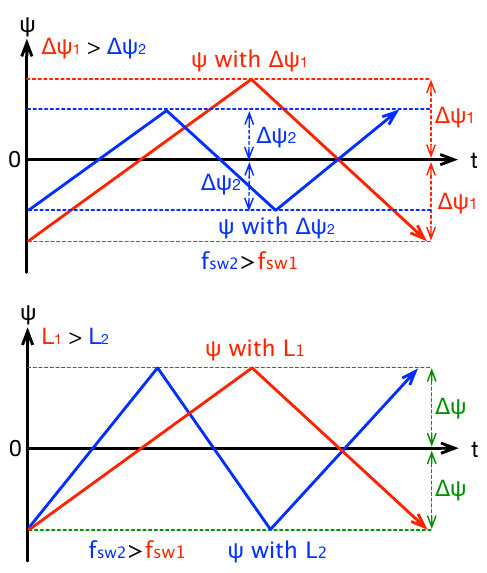
Figure 2. Ψ waveform for different values of ∆Ψ and L .